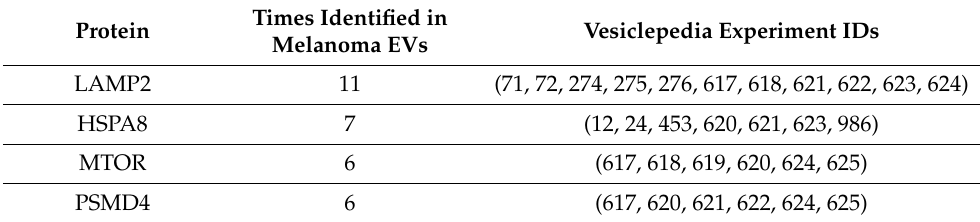
Table 1. Autophagy-related proteins are found in melanoma